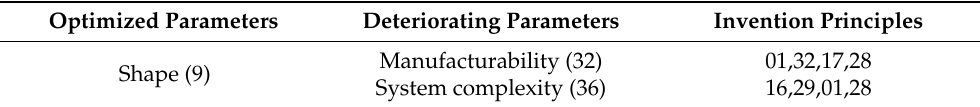
Table 3. Technical conflict matrix of conductive center pole